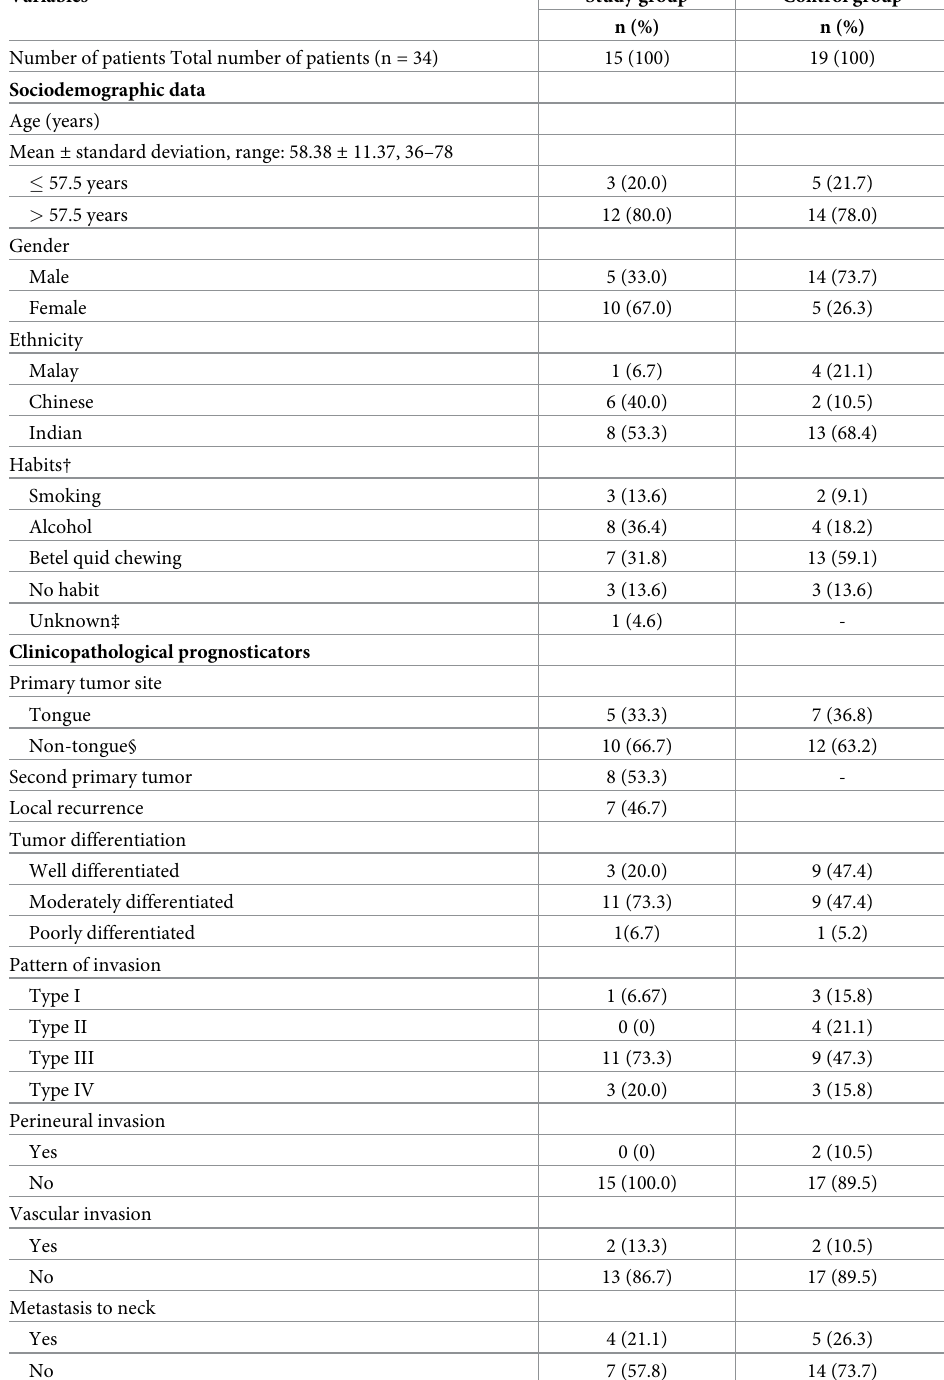
Table 2. Sociodemographic data and clinicopathological prognosticators of